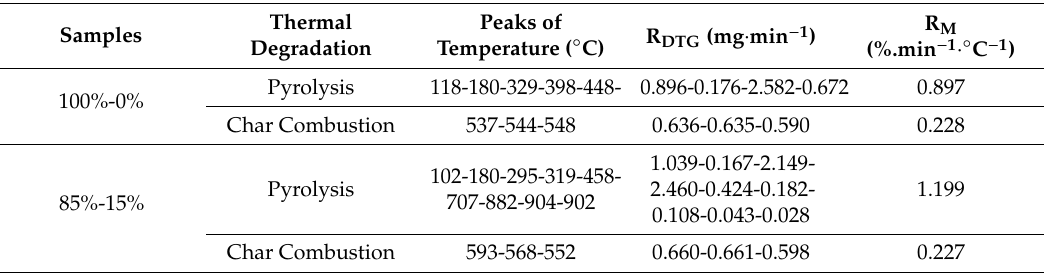
Determination of the mean reactivity of the biofuels during the pyrolysis and the char